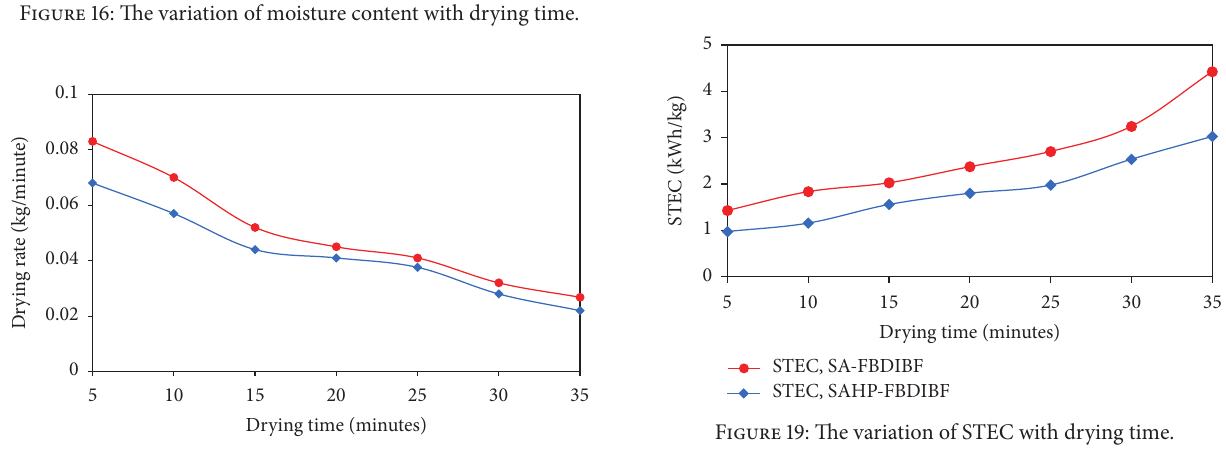
Figure 19: The variation of STEC with drying